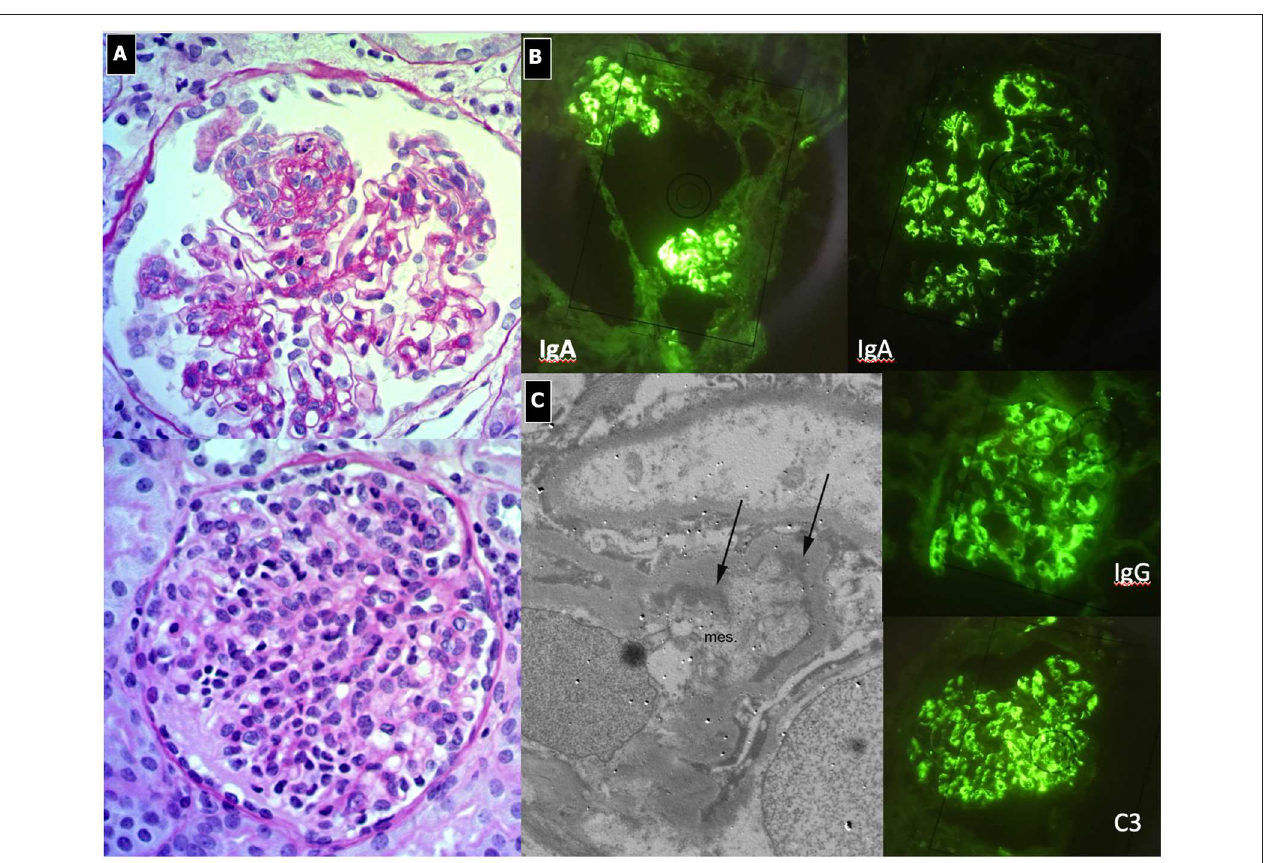
FIGURE 7 | IgA Nephropathy. (A) LM (PAS stain): Two glomeruli show diffuse and global mesangial proliferative lesions, with endocapillary proliferation. (B) IF, global and diffuse mesangial IgA deposits, associated with C3 and IgG deposition. (C) EM, presence of paramesangial immune deposits (arrows).